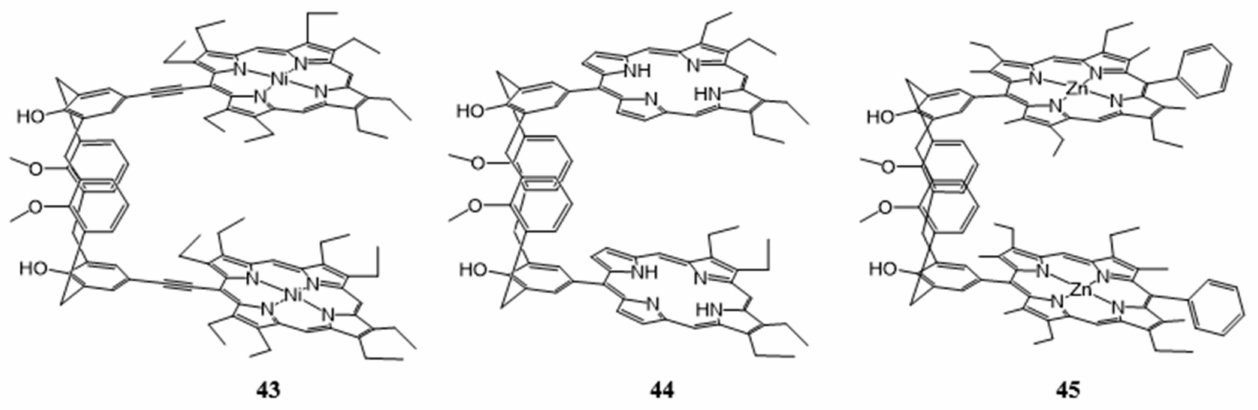
Figure 6. Structures of the Bis-porpjhyrins 43 – 45